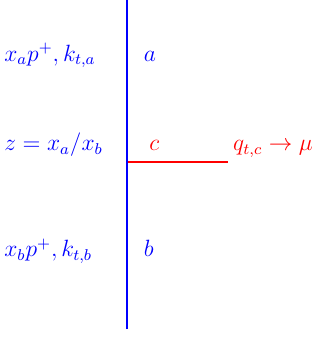
Figure 2 . Branching process b